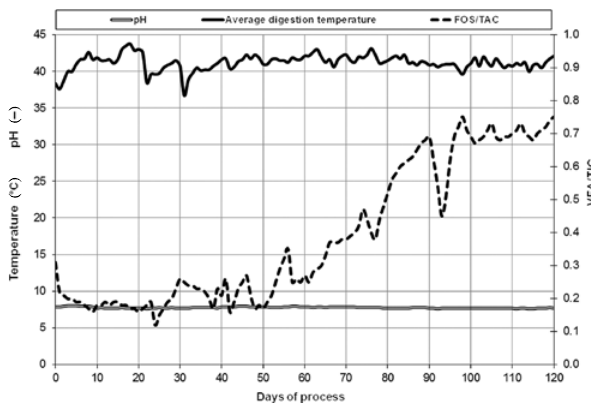
Figure 2: The progress of the temperature, FOS/TAC and